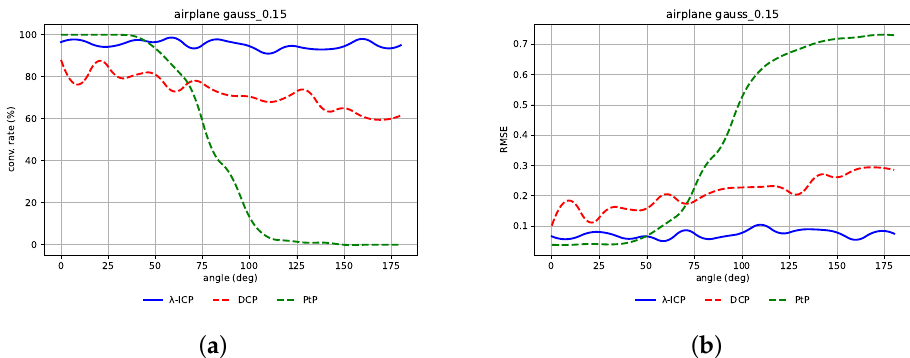
Figure 15. ( a ) Convergence rate of λ -ICP (blue), DCP (red), PtP (green) algorithms for airplane with Gaussian noise, σ = 0.15; ( b ) mean RMSE (for transformation matrices) of λ -ICP (blue), DCP (red), PtP (green) algorithms for airplane with Gaussian noise, σ = 0.15.